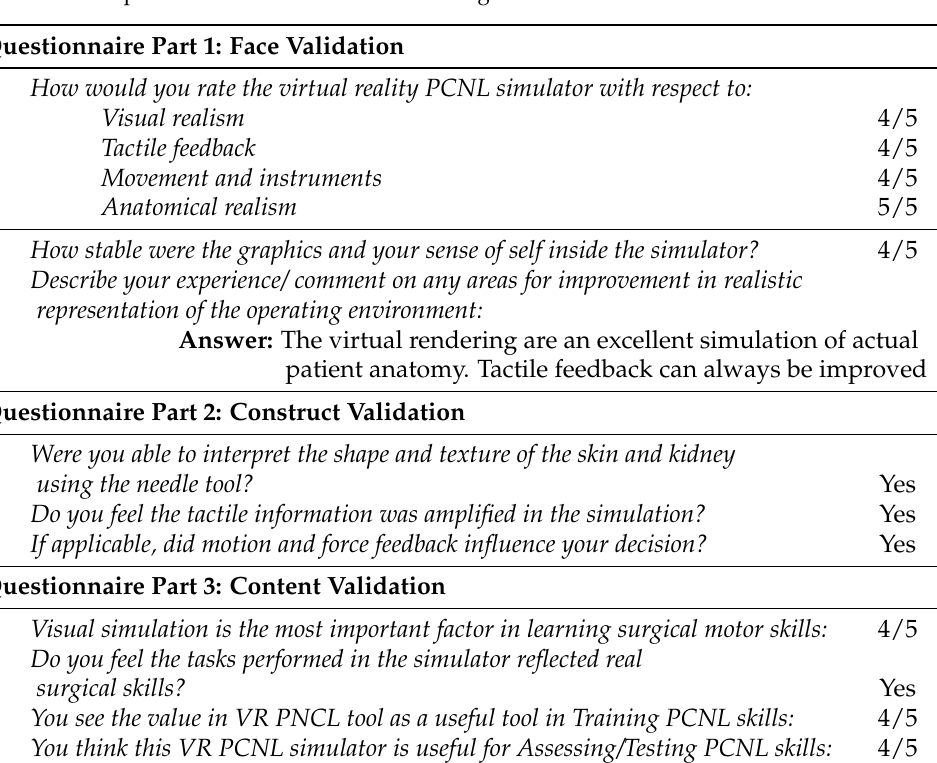
Table A2. Postoperative Assessments: Parts 1 through